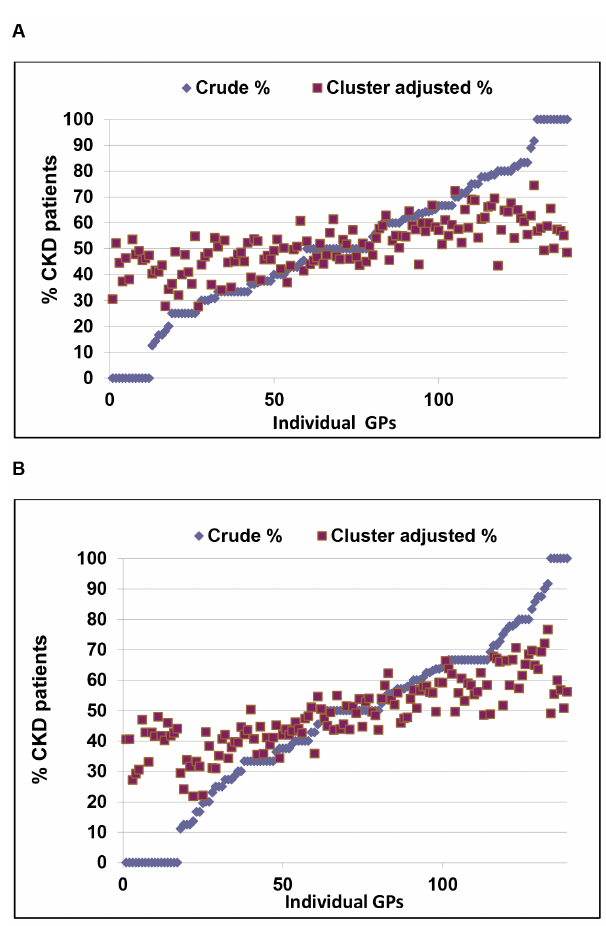
Figure 3. Crude and Cluster-adjusted analysis of CKD patients’ CND prescription by GP. Distribution (%) of CKD patients who received at least one prescription of contraindicated nephrotoxic drugs (CND) within the year prior (A) and after (B) first CKD diagnosis, clustered by GP. The distribution was clustered by GP and the was adjusted also by sex and age. CND: contraindicated nephrotoxic drug.